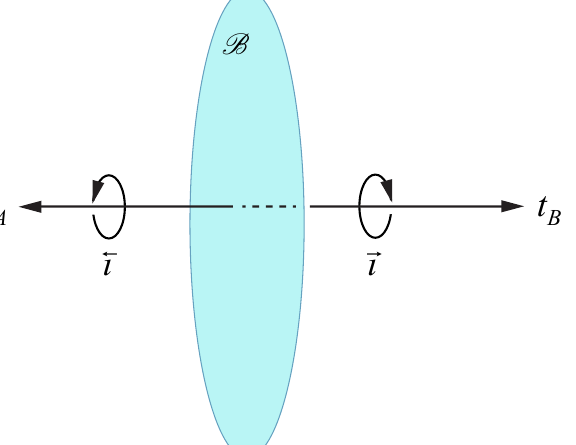
Figure 6: Local times t A and t B flow in opposite directions across B . Each “write” or “prepare” operation on B thus im- −→ plements a Wick rotation ı of the local time, with a total ener- getic cost of a combined write-read of at least h / ln(2)( K B T A ) .